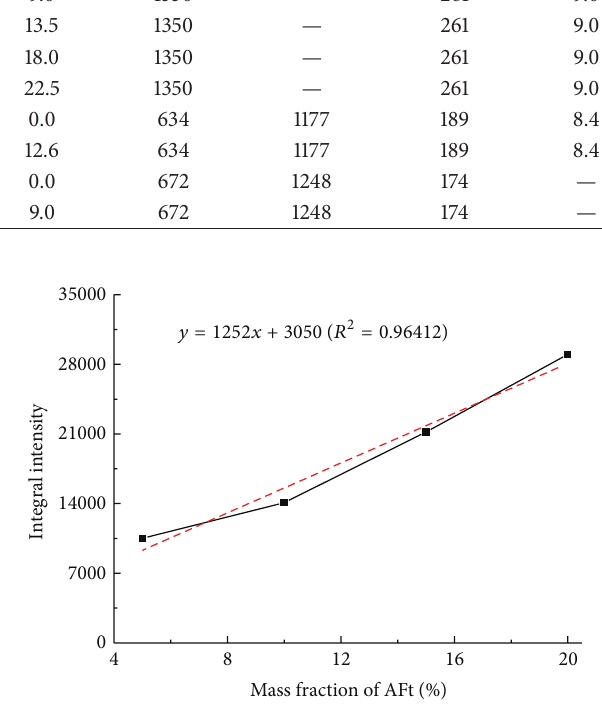
Figure 3: External standard curves of synthetic